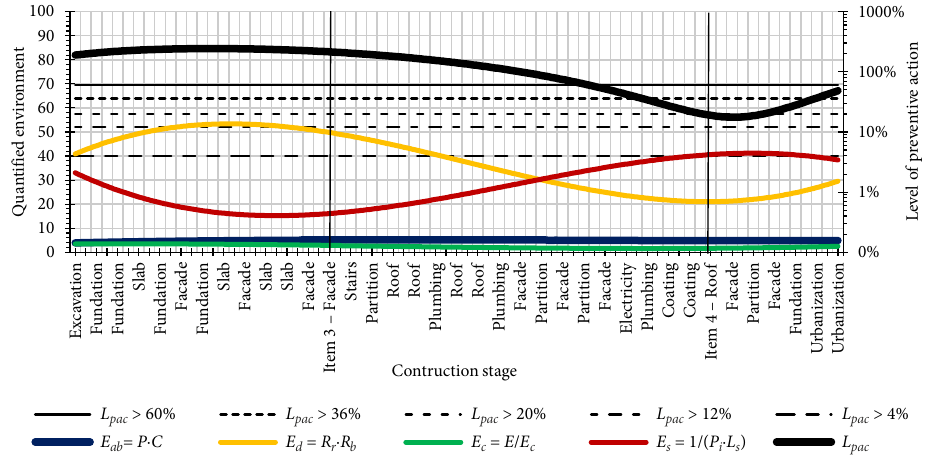
Figure 5. Preventive action environments regarding the risk of thermal stress